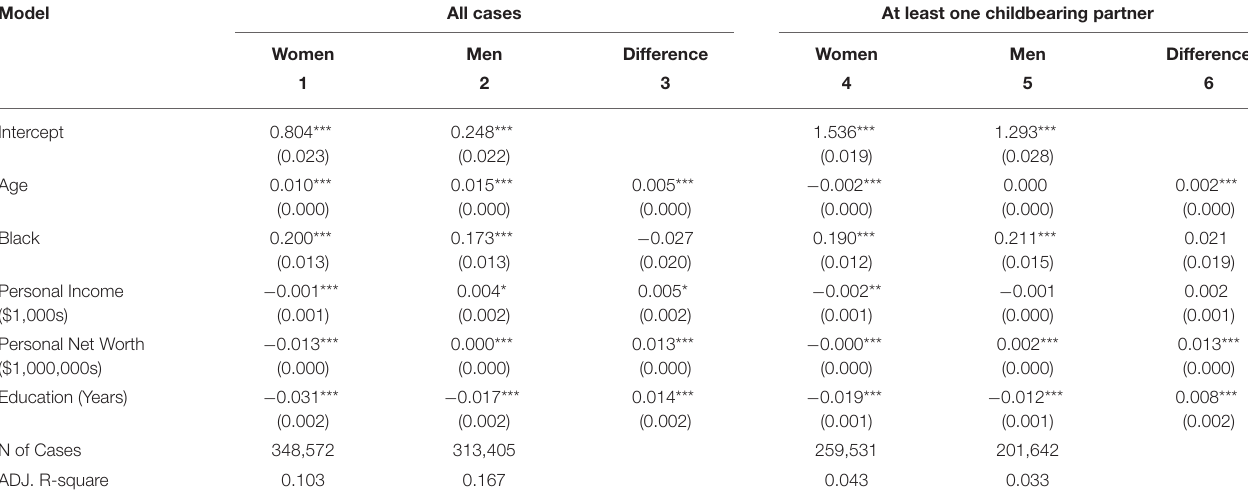
TABLE 3 | Number of childbearing unions by income, net worth, and